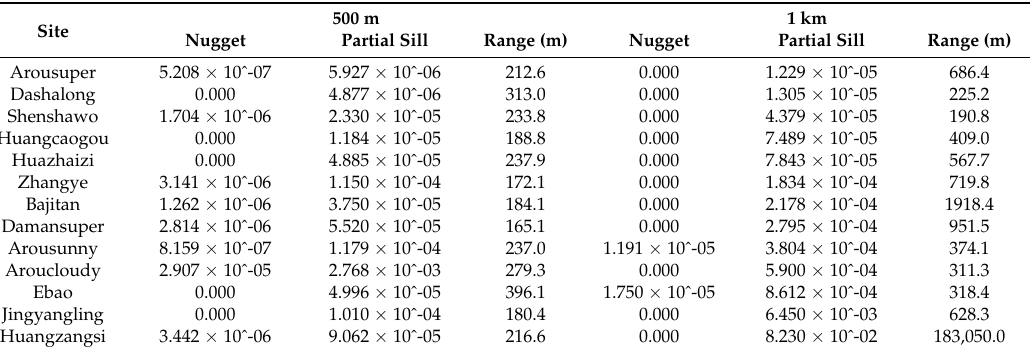
Table 3. Variogram model parameters over these